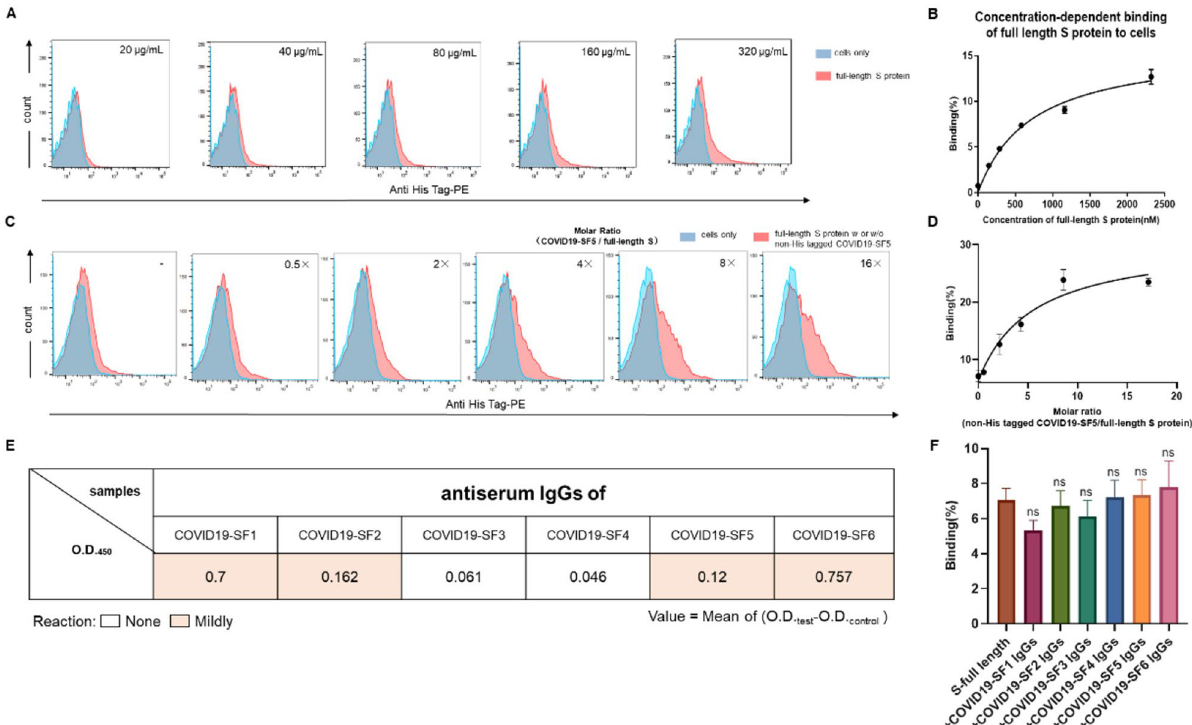
Figure 6. The effect of COVID19-SF5 and S protein fragment anti-serum antibodies on the binding of full- length glycosylated S protein to the cells. ( A and B ) A concentration-dependent binding of the full-length S protein to VERO-E6 cells. VERO-E6 cells were incubated with a series of concentrations (0–320 μg/mL) of His- tagged full-length spike protein. The blue curves represent the cells only. The red curves represent the full-length S protein binding to the cells. The quantified data were shown in the right panel. Mean values of 3 biological replicates ± SD (standard deviation) were shown. ( C and D ) Flow cytometry characterizing the enhancement of non-His tagged COVID19-SF5 on full-length S protein binding to VERO-E6 cells. VERO-E6 cells were incubated with a series of concentrations of non-His tagged COVID19-SF5 to His-tagged full-length spike protein (molar ratio from 0.5 to 16: 1), and His-tagged full-length spike protein bound to VERO-E6 cells were detected by flow cytometry. The blue curves represent the cells only. The red curves represent the full-length S protein itself or with non-His tagged COVID19-SF5. The quantified representative was shown in the right panel. Mean values of 3 biological replicates ± SD (standard deviation) were shown. Data were a representative of 3 independent experiments. ( E ) Reactions of the anti-serum antibodies (0.05 μg/mL) against 6 protein fragments with full-length S protein (10 μg/mL) by ELISA characterization. Light pink indicates intermediate reaction (1 > O.D. test − O.D. control > 0.1), and white indicates no reaction (O.D. test − O.D. control < 0.1). Mean values of 3 biological replicates were shown. ( F ) Flow cytometry determination of the effects of 6 anti-serum antibodies on the binding of full-length S protein to VERO-E6 cells. Cells were incubated with His-tagged full-length spike protein (35 μg/mL) and anti-serum IgGs (10 μg/mL) against 6 protein fragments. Mean values of 3 biological replicates ± SD (standard deviation) were shown (one-way